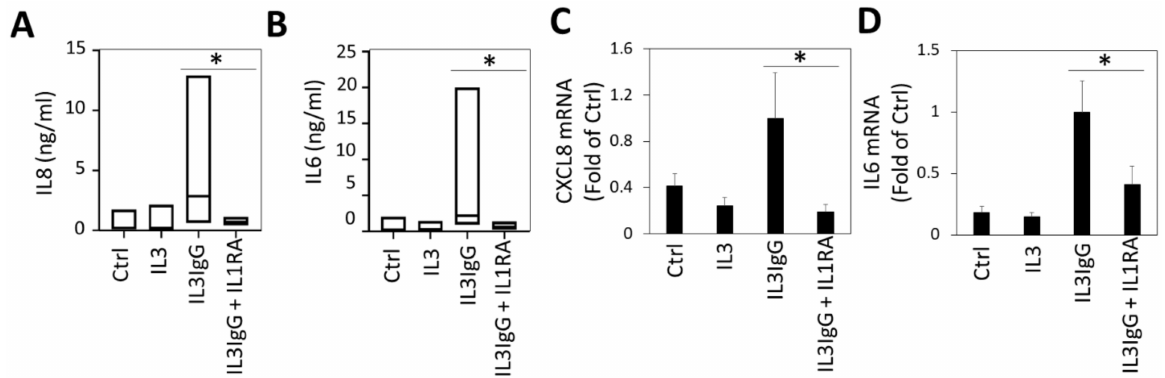
Figure 1. Interleukin 6 (IL6) and IL8 expression and secretion by human bronchial fibroblasts stimulated with eosinophil- derived soluble mediators requires signaling via the IL1 receptor. Human bronchial fibroblasts (HBF) were incubated with IL1 receptor antagonist (IL1RA, 100 ng/mL) or vehicle (0.1% bovine serum albumin (BSA) in PBS) for 30 min, and subsequently stimulated with eosinophil supernatants (IL3 or IL3IgG) or basal medium (Ctrl). Twenty-four hours later, HBF supernatants were analyzed via ELISA for levels of IL8 ( A ) and IL6 ( B ) ( n = 8 for all conditions), and paired Student’s t -test was used to test for statistical significance (* p < 0.05). HBF lysates were analyzed for mRNA levels of CXCL8 ( C ) and IL6 ( D ) via RT-qPCR ( n = 3 for all conditions) and analyzed by setting IL3IgG as a reference (mean ± sd) and using unpaired Student’s t -test to test for statistical significance (* p <